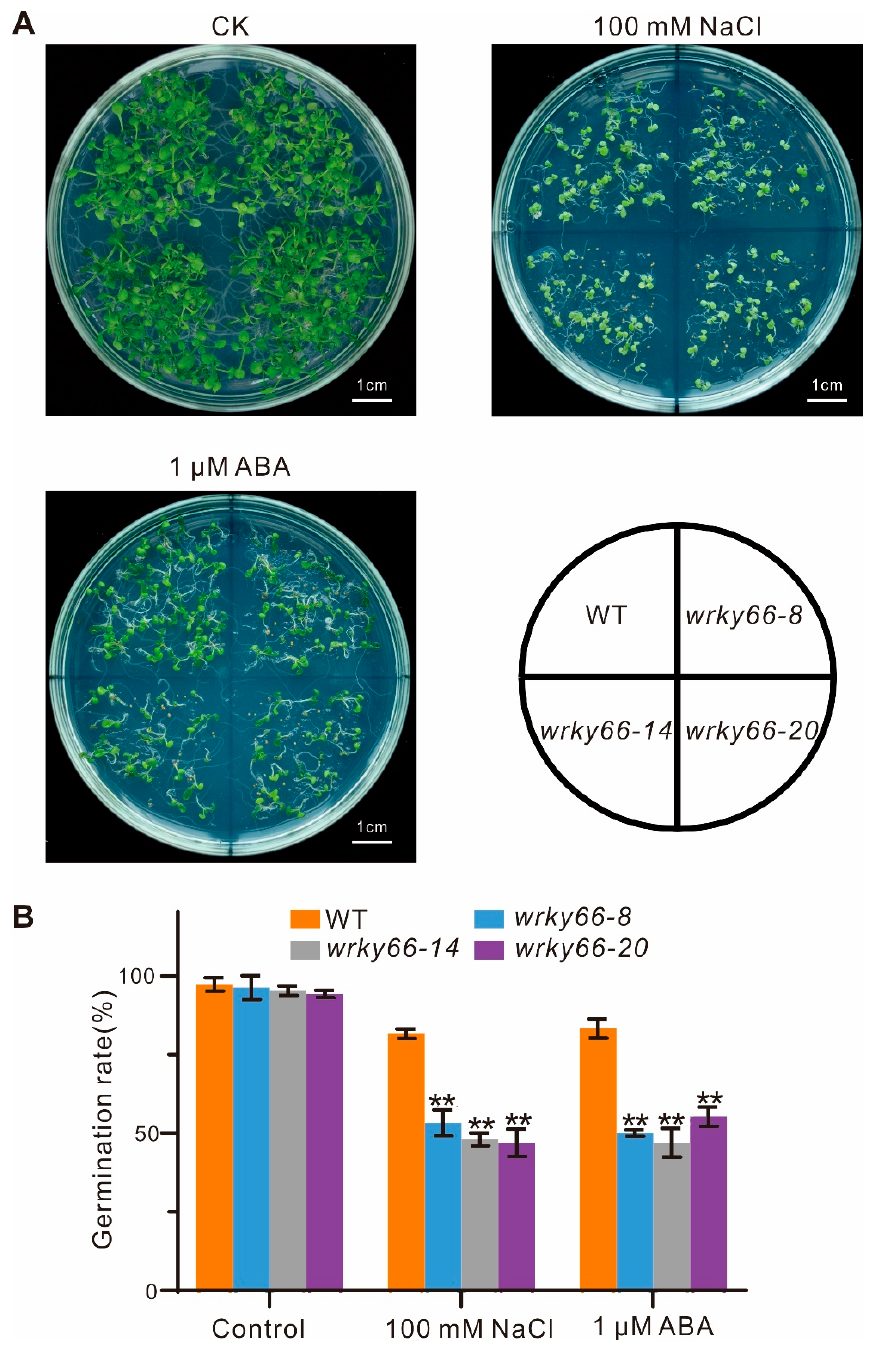
Figure 6. Effects of AtWRKY66 mutations on seed germination under salt stress or ABA treatment. ( A ). Morphology of the germinating seeds of the wrky66 plants compared with those of the WT plants under salt stress or ABA treatment. Pictures were taken on the 10th day after imbibition. Bar indicates 1 cm. ( B ). Seed germination was measured during the 10th day after imbibition in the WT and three wrky66 mutants with or without treatment of NaCl (100 mM) or ABA (1 µM). Values were the mean ± SD, ** p < 0.01.